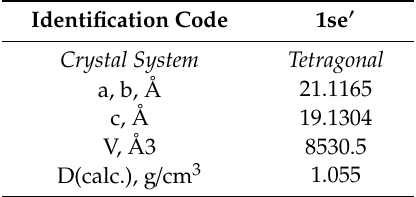
Table A2. Refined unit cell parameters for 1se (cid:48)